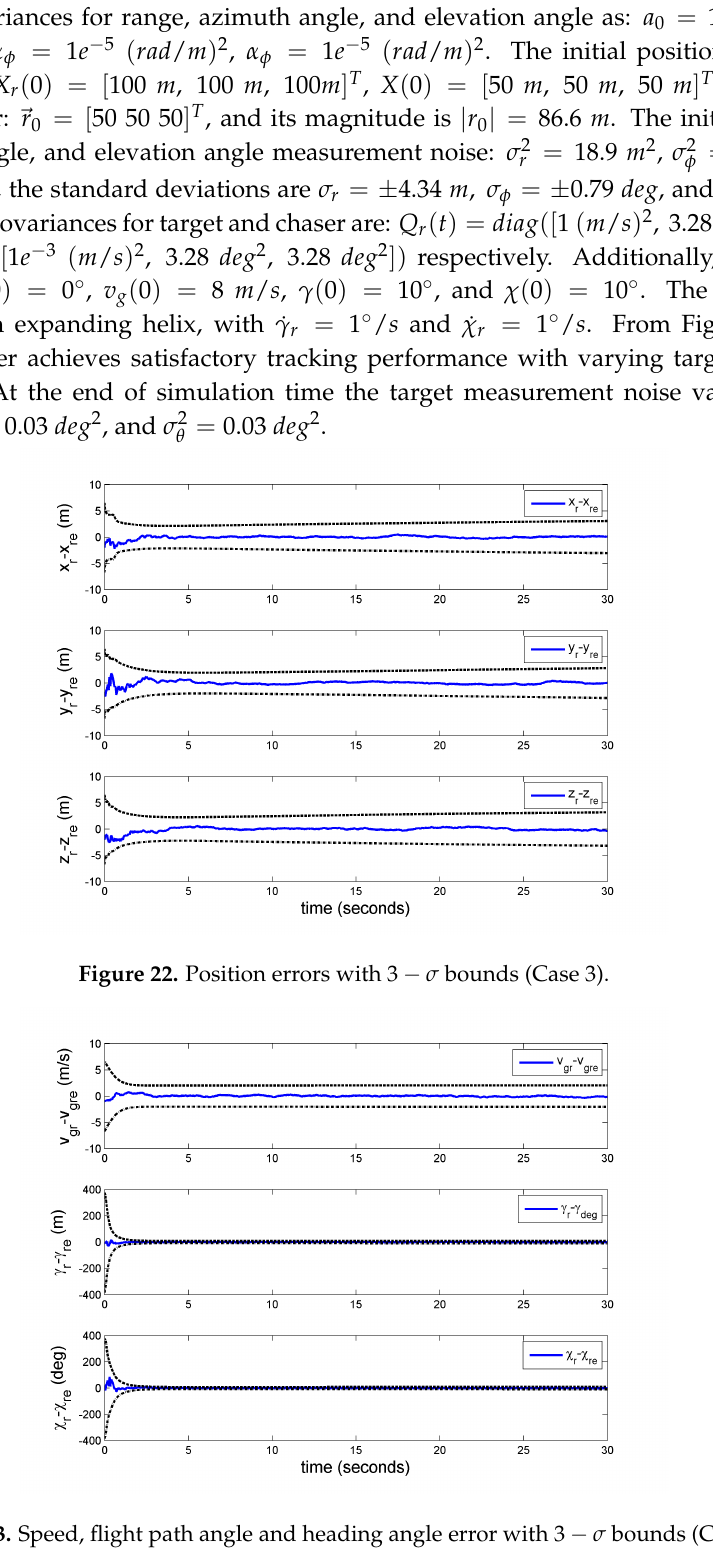
Figure 23. Speed, flight path angle and heading angle error with 3 − σ bounds (Case